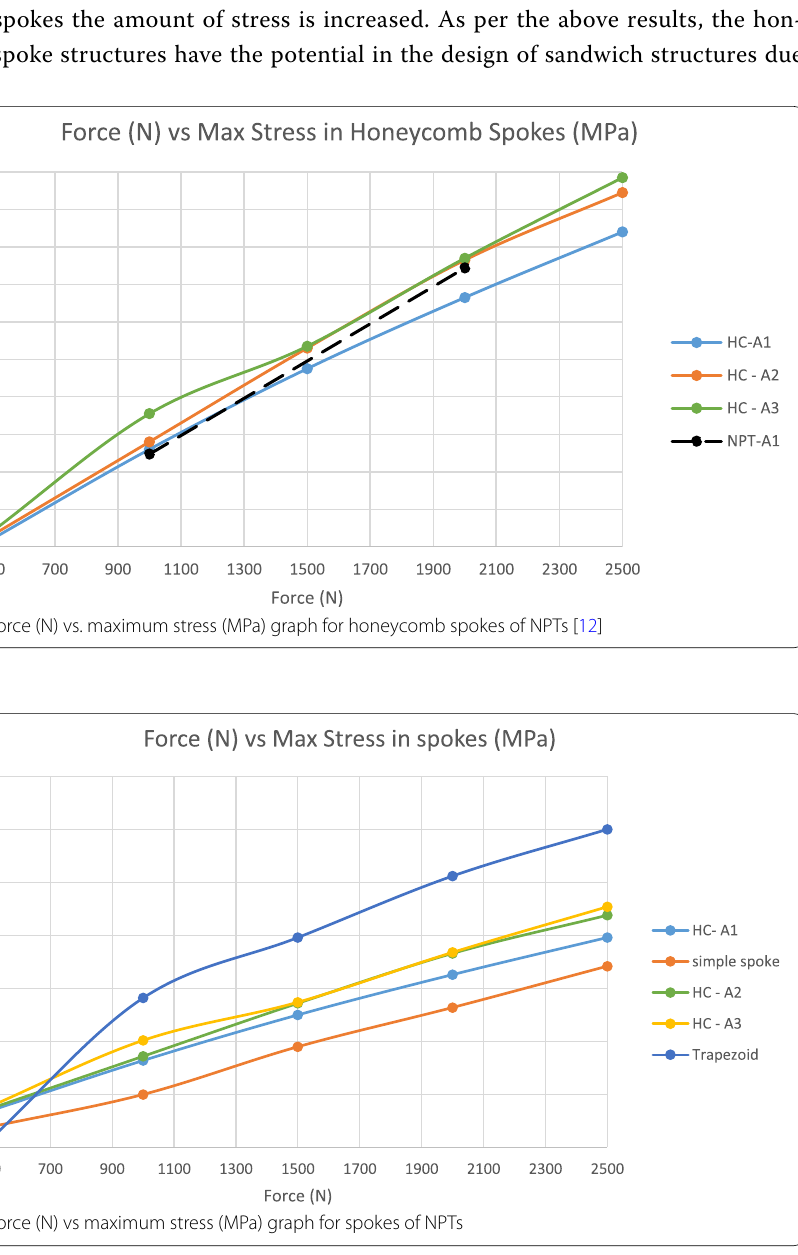
Fig. 12 Force (N) vs maximum stress (MPa) graph for spokes of